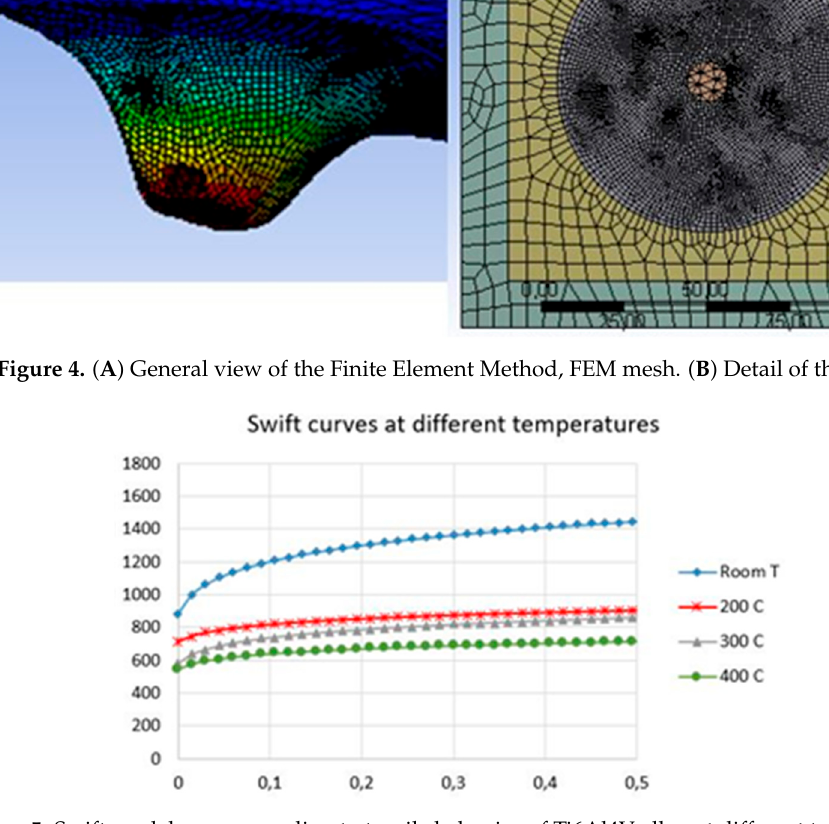
Table 2. Single Point Incremental Forming tests of truncated cones with constant and variable wall angles. The angle in brackets establishes the maximum value angle with no breaking during the test in variable wall angle tests.